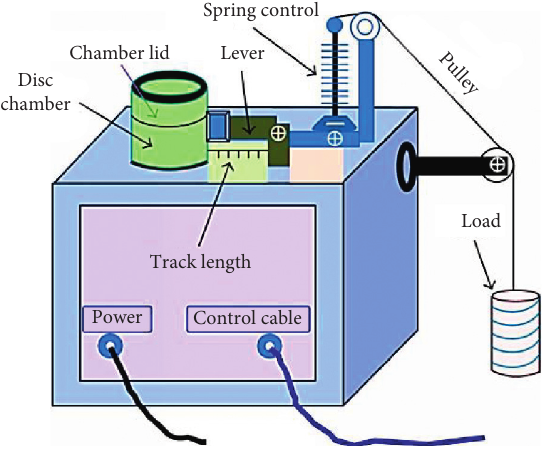
Figure 4: Pin on disc apparatus. Table 2: The specifications of pin on disc